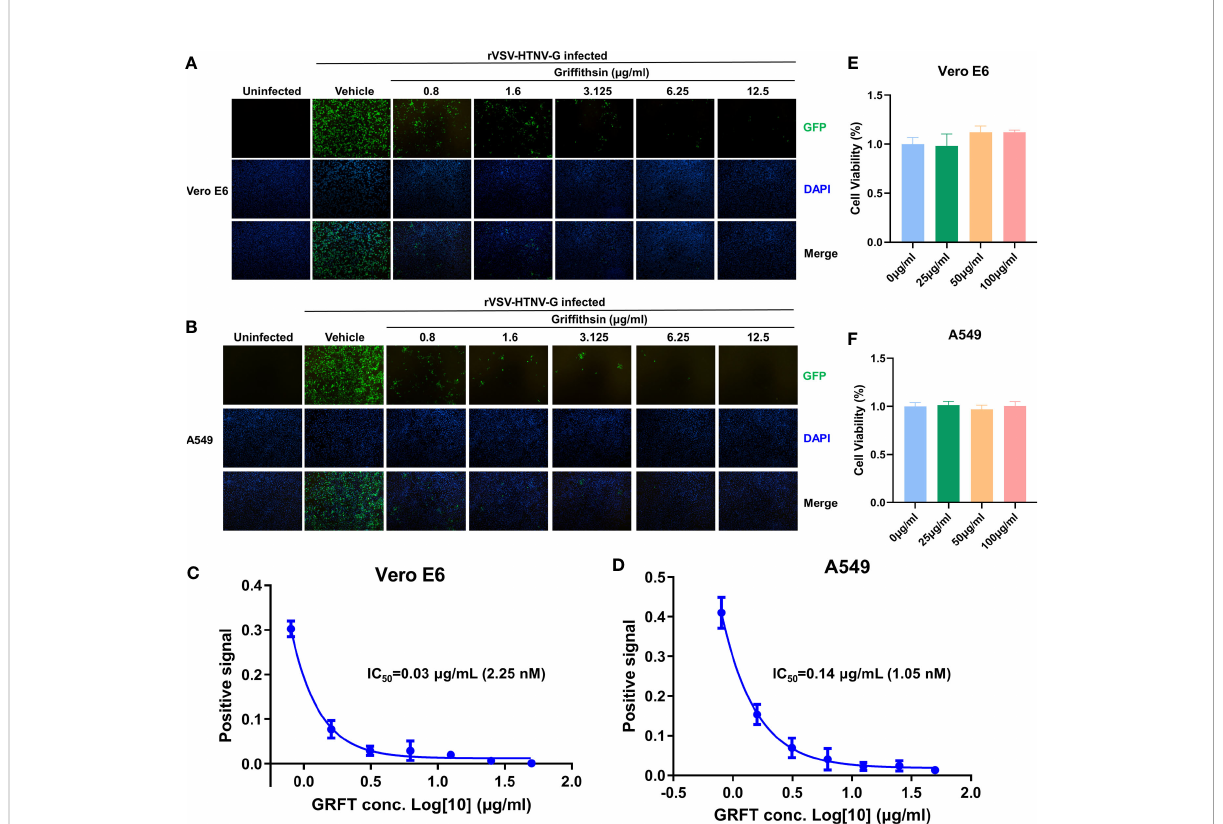
FIGURE 2 GRFT inhibits rVSV-HTNV-GFP entry. The recombinant vesicular stomatitis virus harboring HTNV glycoproteins (rVSV-HTNV-G) and GFP were treated with varying concentrations of GRFT for 1 h, and then the mixture was used to infect Vero-E6 (A) or A549 (B) cells at an MOI of 1. At 24 h post-infection, cell nuclei were stained with Hoechst 33258 and observed under an inverted fl uorescence microscope. Green, GFP, indicates the replication of rVSV-HTNV-G; blue, cell nuclei. (C,D). The dose – response curve shows the quanti fi cation of GFP-positive Vero-E6 (C) or A549 (D) cell area after GRFT treatment of rVSV-HTNV-G (normalized with the positive control, the fi rst point in the fi gure shows the fi rst GRFT treatment concentration instead of positive control). (E, F) Cell viability was measured 72 h after drug administration using the Cell Counting Kit-8 (CCK8), and absorbance for Vero E6 (E) cells and A549 (F) cells was measured at 450 nm using the BioTek HT collaborative instrument. A450 levels were subtracted from blank well background, and untreated cells were set at 100% viability. Data shown in the graphs are presented as the mean ± SD and are representative of three independent experiments performed in hexaplicate. GRFT, grif fi thsin; rVSV, recombinant vesicular stomatitis virus; HTNV, Hantaan virus; GFP, green fl uorescent protein; MOI, multiplicity of